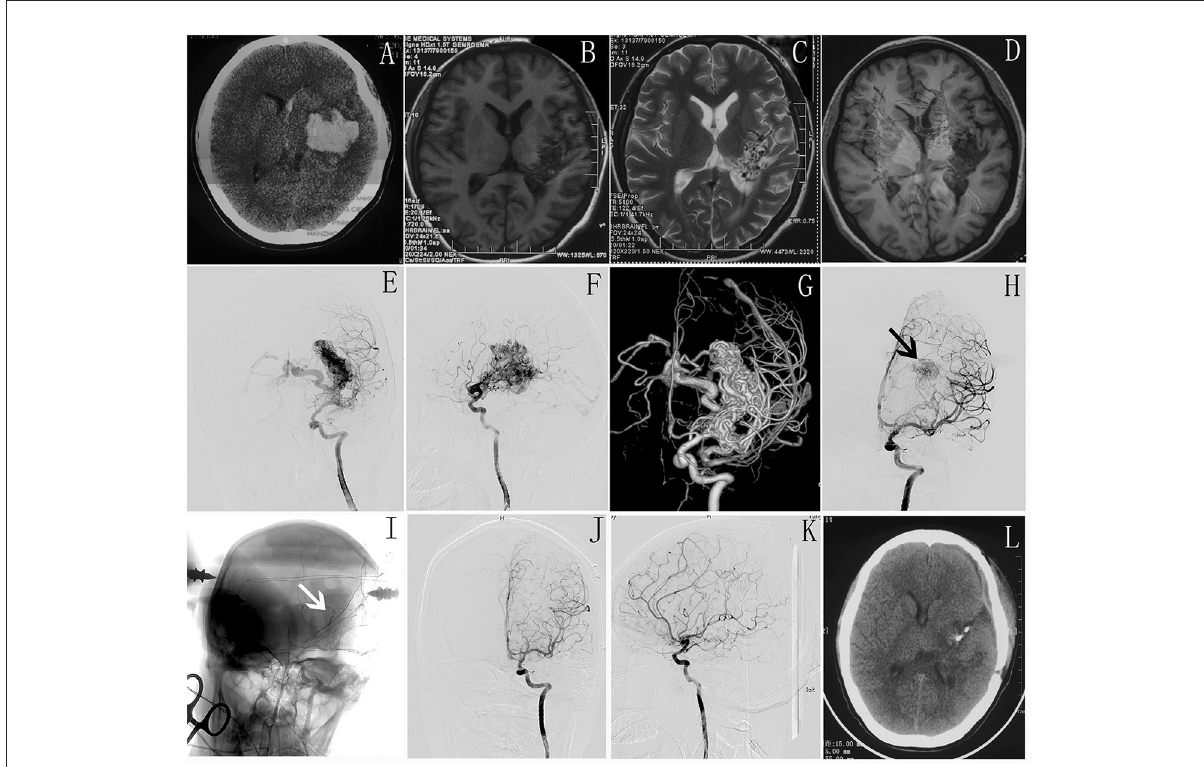
FIGURE2 (A) Preoperative CT shows intracranial hematoma in left basal ganglia. (B–D) MR scan shows malformed vascular mass in left basal ganglia and some damage in corticospinal tract. (E–G) Intraoperative DSA shows AVM located in basal ganglia. (H,I) Intraoperative DSA shows the residual AVM nidus (white arrow) and a clipper used as markers to accurately locate the residual AVM lesion(black arrow). (J,K) The immediate postoperative DSA shows complete occlusion of AVM. (L) postoperative CT scan shows no more damage in the normal brain